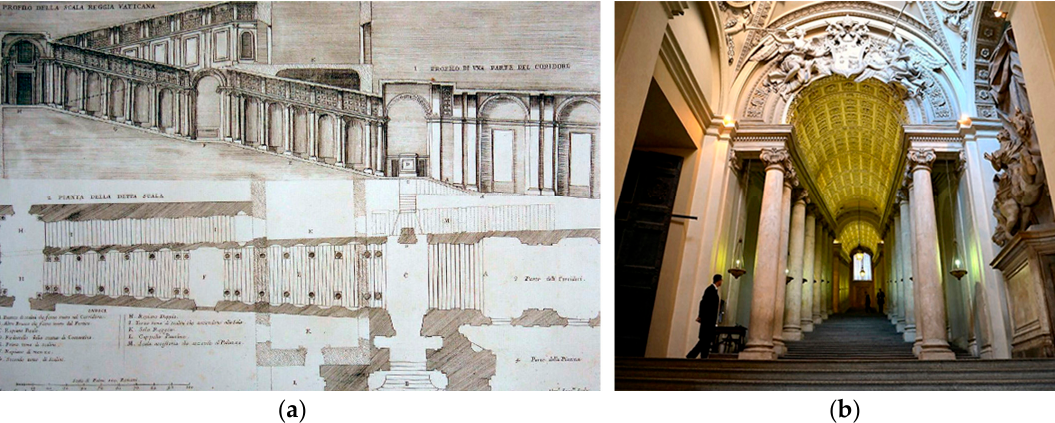
Figure 2. The perspective deception as a scientifically controllable expedient: Gian Lorenzo Bernini’s Scala Regia in Vatican, 1663–1666. ( a ) Drawings; ( b )